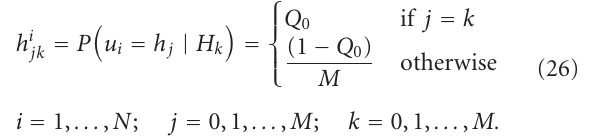
PCS of the fusion system is improved while we increase the number of sub-decision methods and the PCS of the sub-decision systems. Also, the increment descends while adding supplemental sub-decision methods. In case of using two damage cases as shown in Figure 2(b), the similar phenomenon is observed. It is also found that using either 2 k − 1 or 2 k sub-decisions will achieve the same PCS of the fusion system, and k = 0, 1, ...